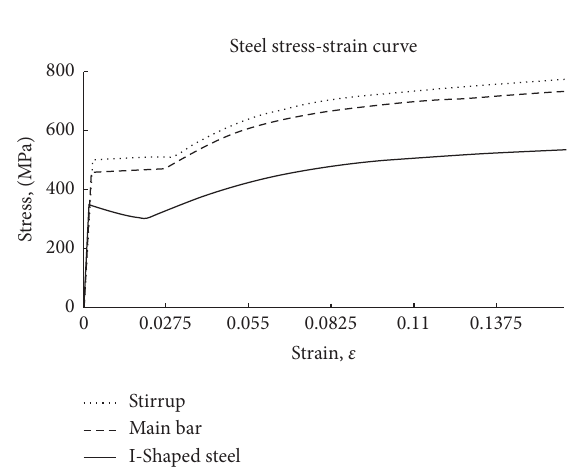
Figure 1: Stress-strain model for structural steel sections and reinforcements [16, 17].